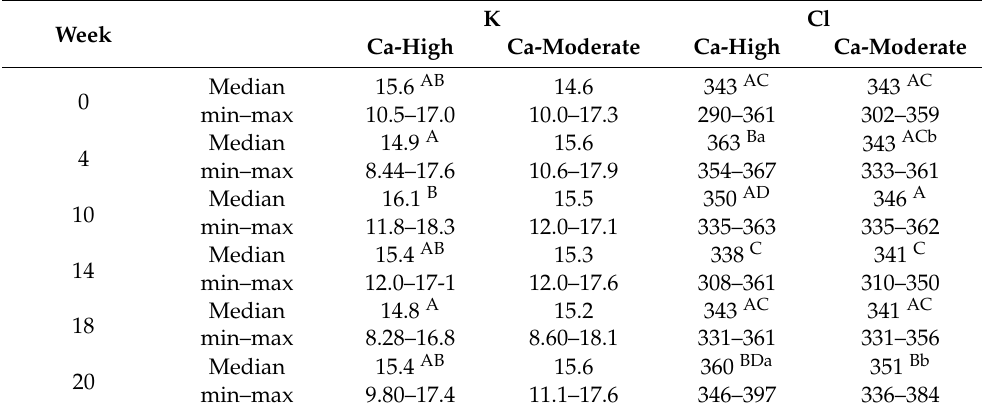
Table 7. Potassium and chloride serum concentrations of the stallions (median, min–max), given in mg/dL. K Cl Week Ca-High Ca-Moderate Ca-High